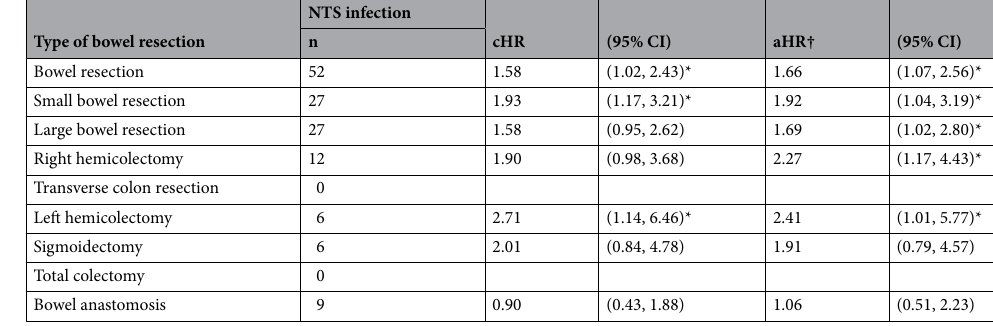
Table 4. Sensitivity Analysis (Excluding Peptic Ulcer Disease Patients). NTS nontyphoidal salmonella, n number of event, cHR crude hazard ratio, aHR adjusted hazard ratio. † Adjusted by age, hypertension, diabetes, coronary artery disease, chronic kidney disease, COPD and rheumatoid autoimmune disease. * p value < 0.05, ** p value < 0.01, *** p value < 0.001.